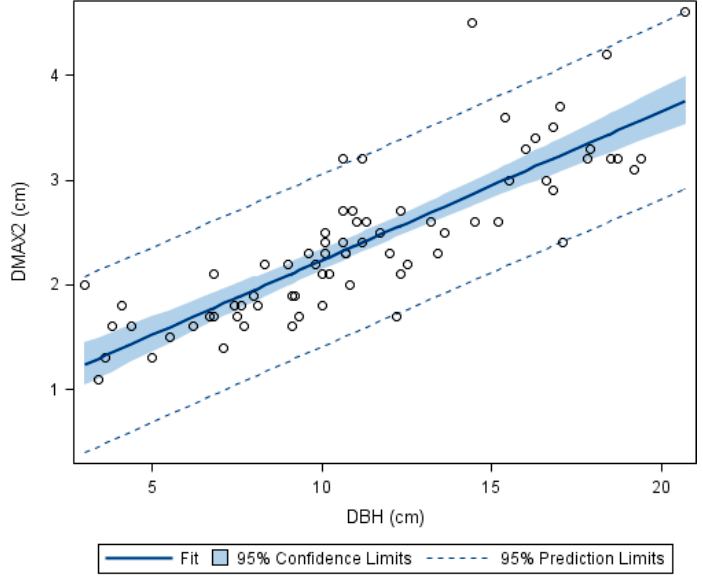
Figure 2. Relationship between maximum branch diameter on the lower 2 m stem section (DMAX2) and tree DBH. Parameter estimates for the linear model are provided in Table 8. Table 8. Linear models describing variation in branch diameter. (DMax2 = maximum branch diameter in the lower 2 m section of the stem (cm); DMax1 = maximum live branch diameter in the whorl closest to 1 m (cm); DMean1 = average live branch diameter in the whorl closest to 1 m (cm); DBH = diameter at breast height (cm); Slenderness = HT/DBH; Aw_Baha = aspen basal area ha − 1 (m 2 ha − 1 ); Aw_sph = aspen stems ha − 1 (# ha − 1 ); CW = Crown width (m); HT = height (m); LCR = live crown ratio (LCR = (HT − HTLC)/HT); HTLC = height to the base of the live crown (m)). ns = model not significant ( α =